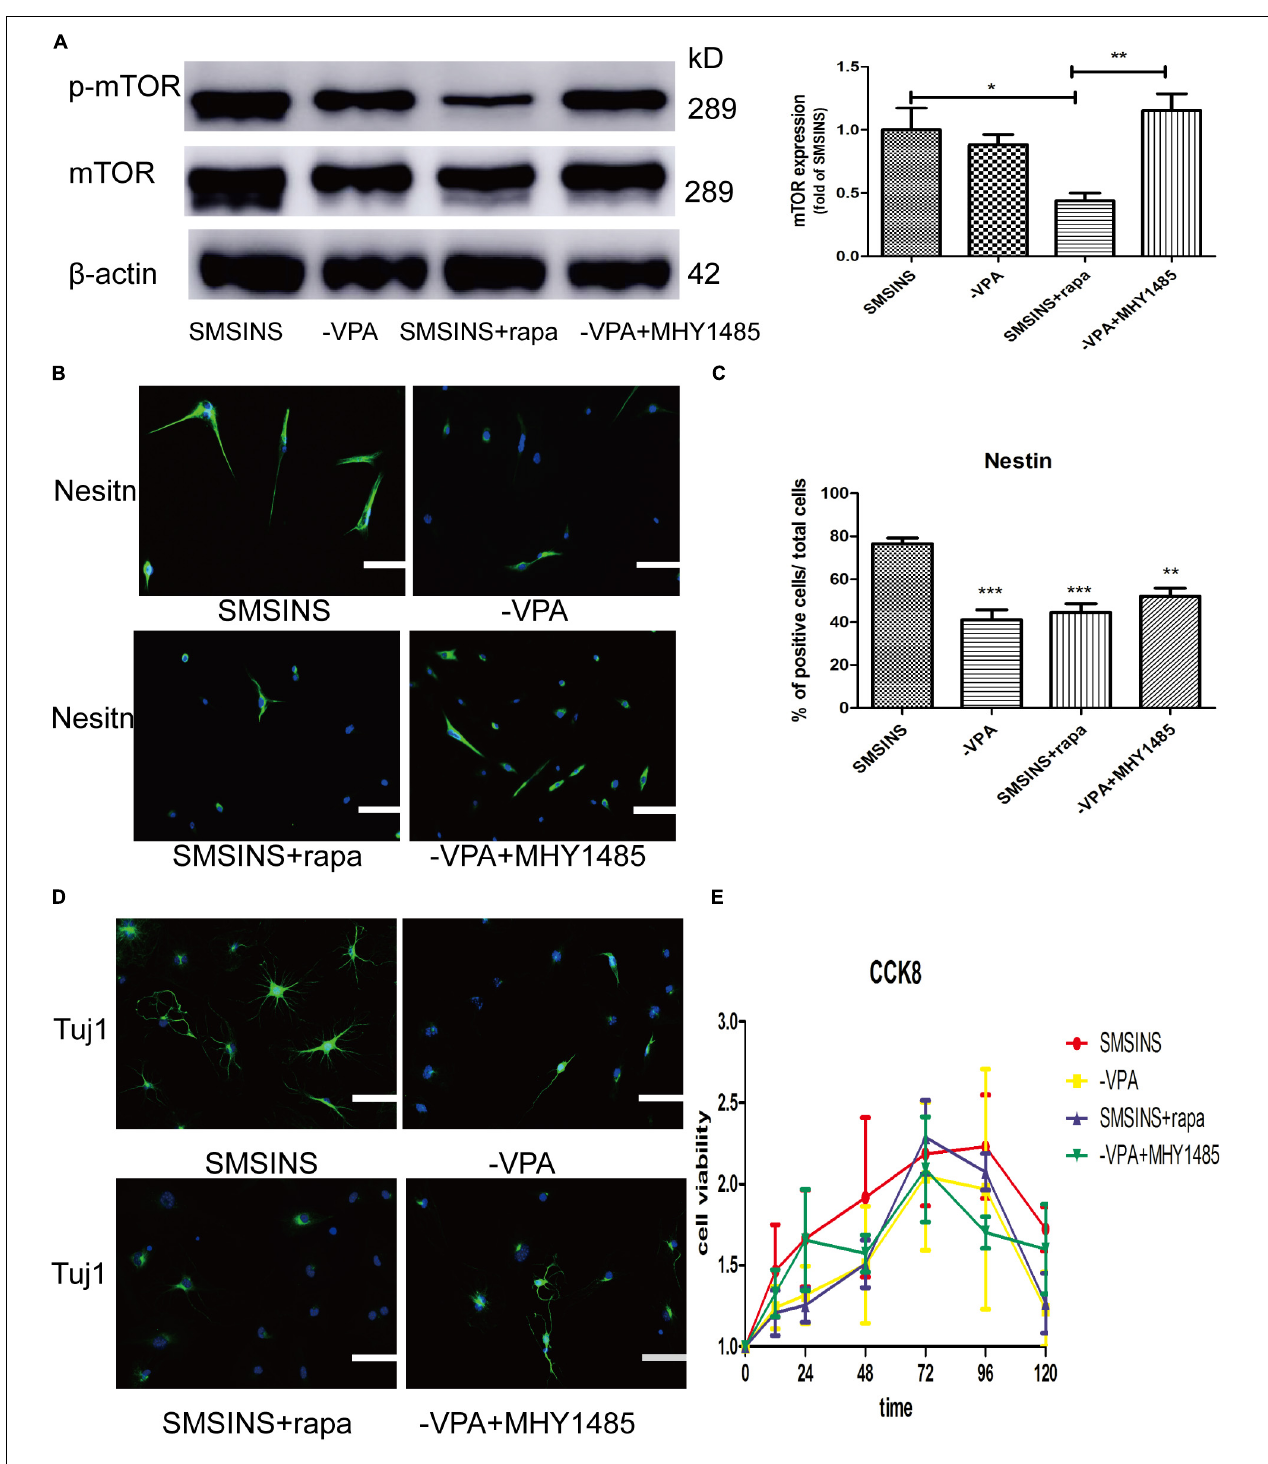
FIGURE 7 | The important role of mTOR activity treated with VPA on SMSINS. (A) Western blots of total proteins extracted from four groups SMSINS, -VPA, SMSINS + rapamycin, and -VPA + MHY1485 using mTOR, phosphorylated mTOR and β -actin antibody. F = 6.566 ∗ p < 0.05; ∗∗ p < 0.01; ∗∗∗ p < 0.001; one-way ANOVA followed with Bonferroni test. (B) Immunostaining of Nestin (Green) in four groups using a specify antibody. Nuclei were counterstained with DAPI (blue). (C) Quantitative analyses showed Nestin expression level of four groups. F = 13.06 ∗ p < 0.05; ∗∗ p < 0.01; ∗∗∗ p < 0.001 compared with SMSINS; one-way ANOVA followed with Bonferroni test. n = 3 batches. (D) Neuronal differentiation potential without growth factors about four groups, as identified by immunostaining against Tuj1 (Green). Nuclei were counterstained with DAPI (blue). (E) Proliferative capacity of four groups was assessed by CCK-8 assay. Data represent the mean ± SEM. Scale bars: 100 µ m (B,D)